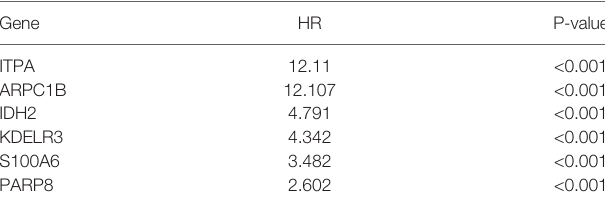
TABLE 1 | Six genes were identi fi ed by Lasso regression to construct a prognostic model. Gene HR